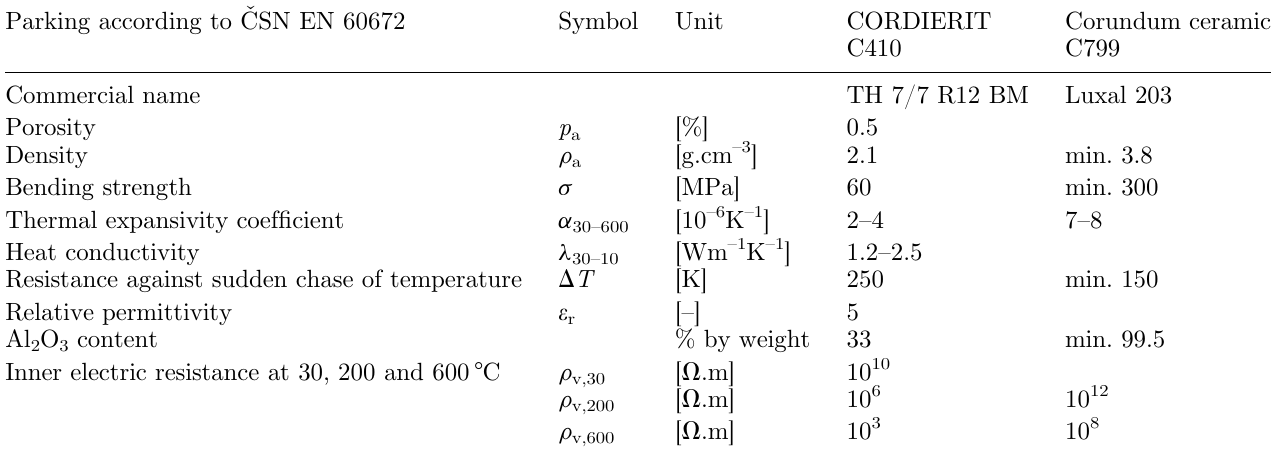
Table 2. Basic parameters of tested ceramics.